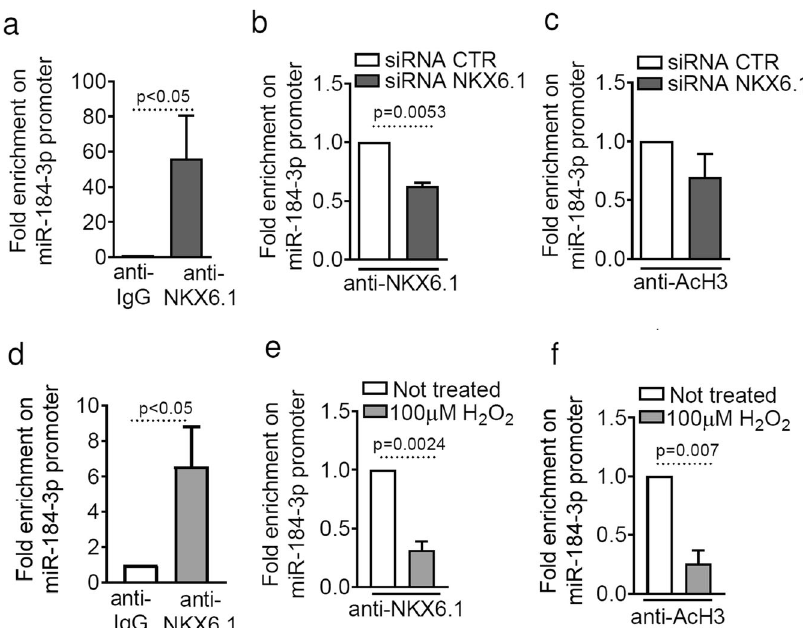
Fig. 6 NKX6.1 binds directly to the miR-184 promoter. a – c ChIP-qPCR of NKX6.1 binding to the human miR-184 promoter sequence; data are shown as fold change in miR-184 promoter sequence bound by anti-NKX6.1 antibody compared to isotypic IgG negative control ( a ). ChIP- qPCR of NKX6.1 binding ( b ) or histone H3 acetylation (AcH3) ( c ) at the miR-184 promoter, with or without NKX6.1 siRNA and normalised to IgG control; values are shown as fold change in EndoC- β H1 cells transfected with NKX6.1 siRNA compared to scrambled siRNA; statistics using Mann – Whitney U test ( n = 4 – 5 independent experiments). d – f ChIP-qPCR of NKX6.1 binding to the selected sequence of the murine miR-184 promoter; data are shown as fold change of anti-NKX6.1 antibody compared to isotypic negative control IgG ( d ); statistics using Mann – Whitney U test ( n = 4 independent experiments). ChIP-qPCR of NKX6.1 binding ( e ) or histone H3 acetylation (AcH3) ( f ) at the murine miR-184 promoter, with or without 100 μ M H 2 O 2 treatment in MIN6 cells; values are shown as fold change of 100 μ M H 2 O 2 treated